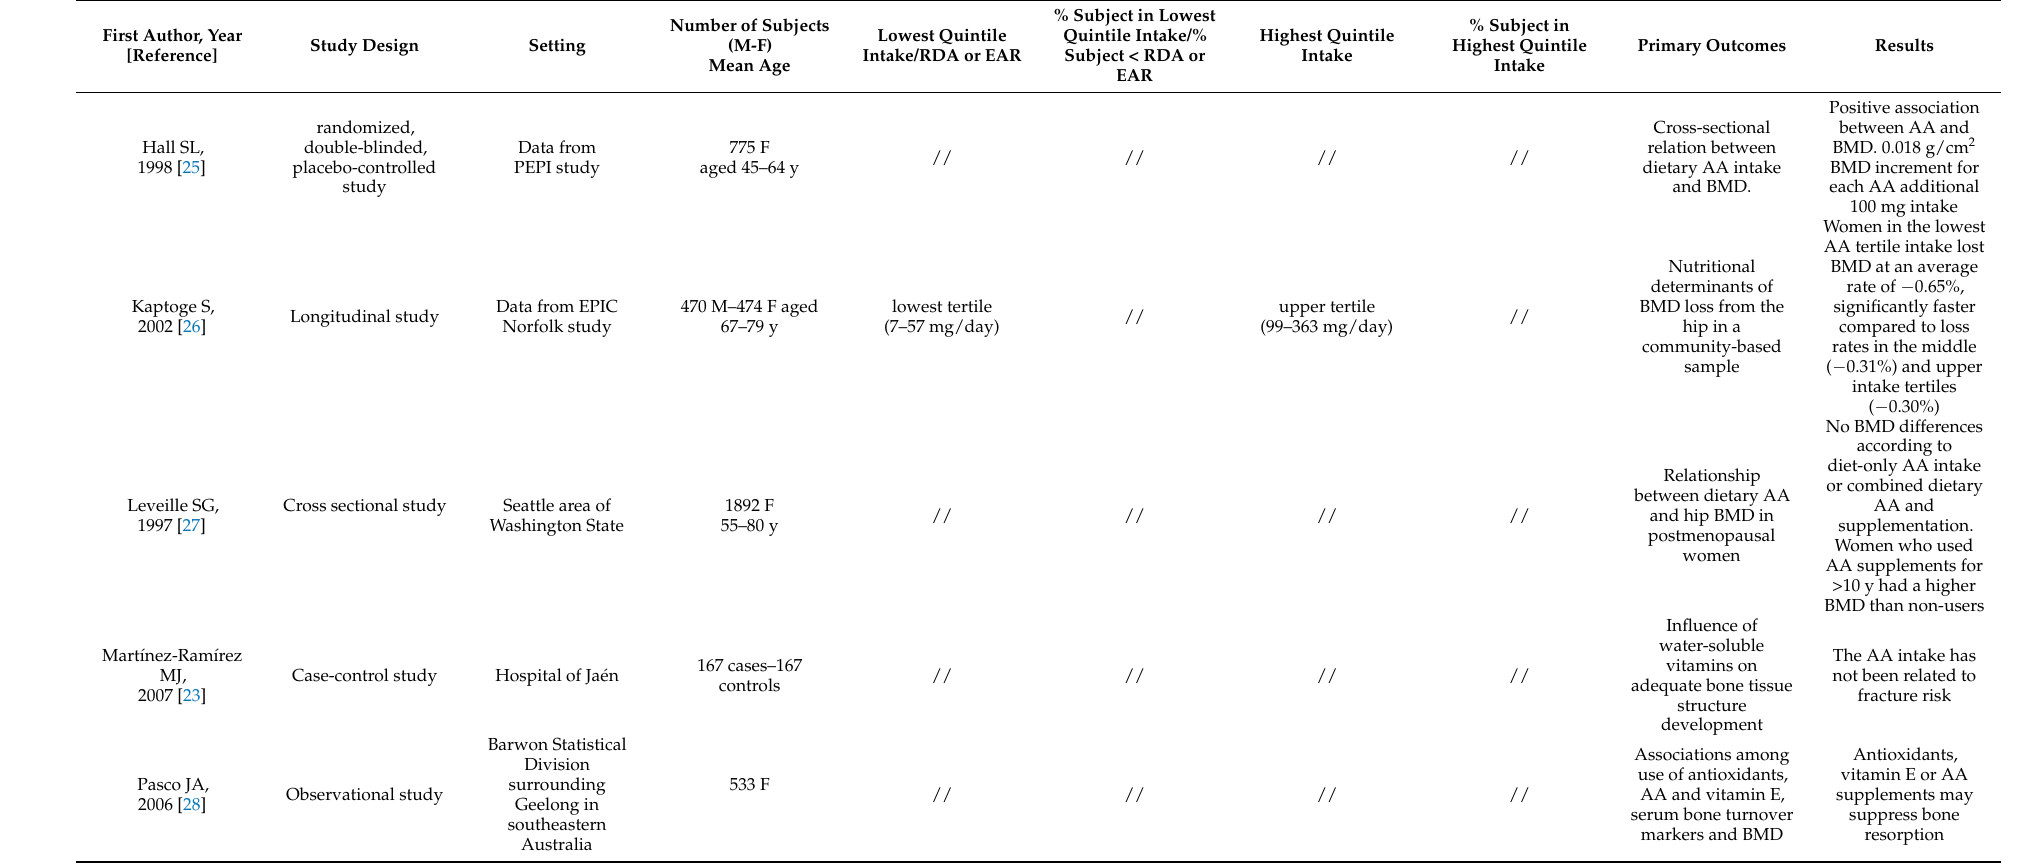
Table 3. Dietary intake of AA and bone